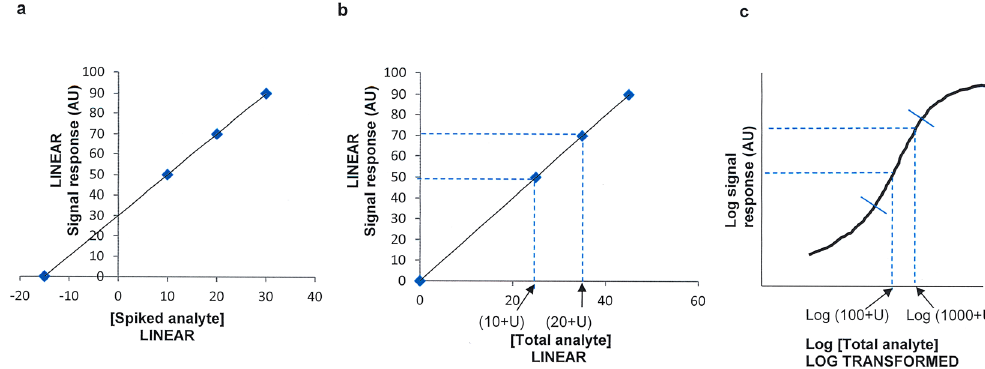
Figure 1. Illustrations depicting conventional standard additions for chemical analytes and biological targets by immunoassay. Figure 1a: A typical plot for illustrating the method of standard additions for chemical analysis. The intercept at -15 indicates the endogenous concentration of the chemical analyte in this example is 15 units. Figure 1b: An alternative view of Supplementary Fig. 1a to show the relationship if the total analyte (not just spike concentration) is plotted on the x-axis, where U denotes the unknown endogenous chemical analyte concentration. If a linear change in the concentration of a chemical analyte exhibits a linear change in response, the gradient can be resolved for the line of fit, and the unknown endogenous concentration can then be determined; i.e. using the equation for a straight line: y = mx + c, where y is the response, x =